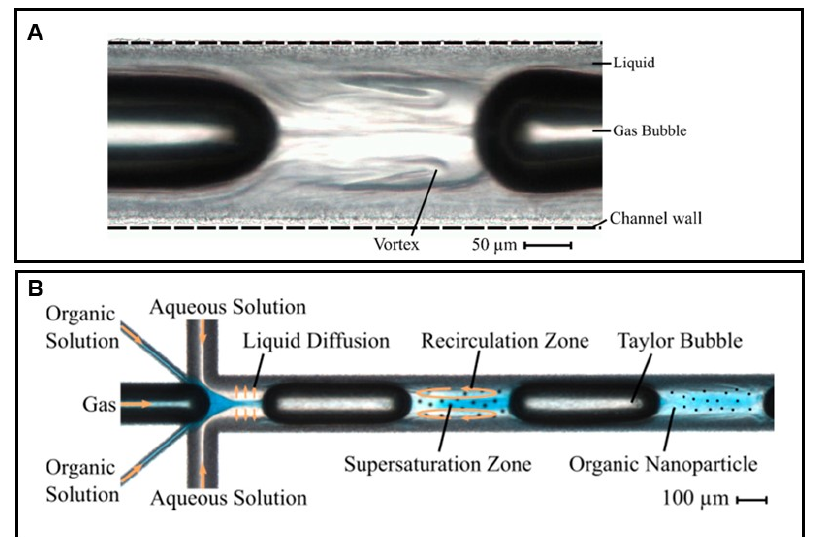
Figure 10. A microscopic view of a transparent microchannel showing vortices in the segmented gas ‒ liquid flow ( A ) and microfluidic system with initial flow-focusing and subsequent Taylor flow ( B ) Reprinted from Ref. [58].